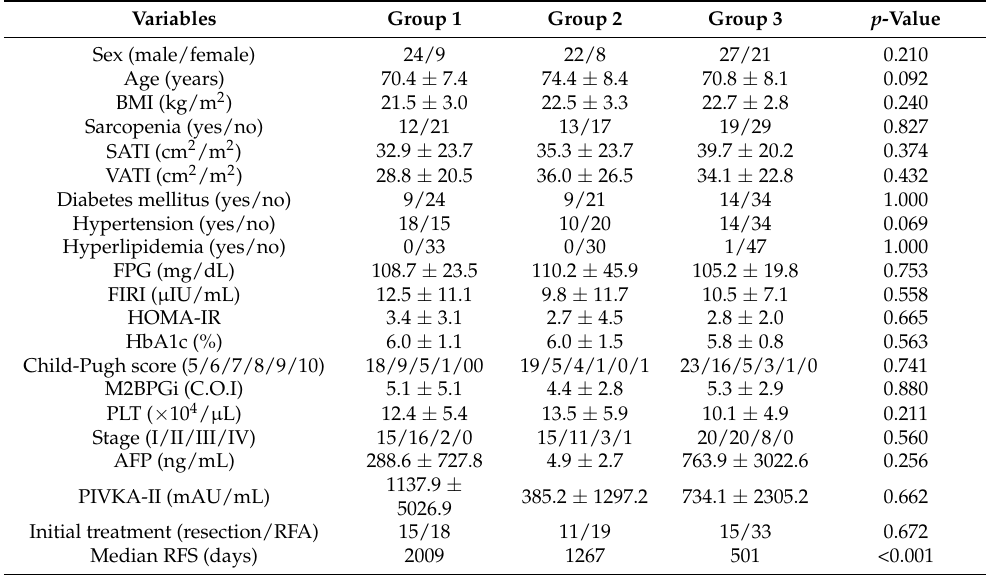
Figure 3. Result of the decision tree analysis on the factors predicting hepatitis C virus-related recurrence of hepatocellular carcinoma. Table 2. Baseline demographic and clinical characteristics are divided into Groups 1, 2, and 3.